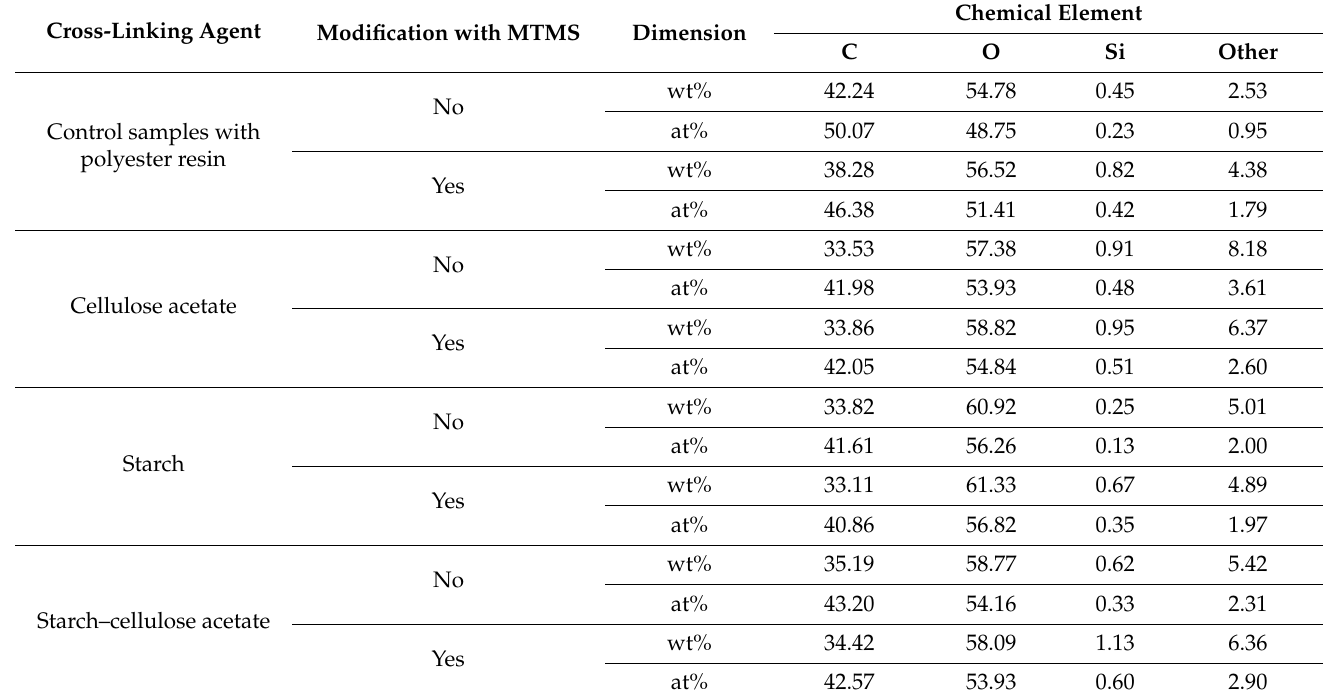
Table 3. Extracted elemental composition from the energy-dispersive X-ray spectra of the aerogels. Cross-Linking Agent Modification with MTMS Dimension